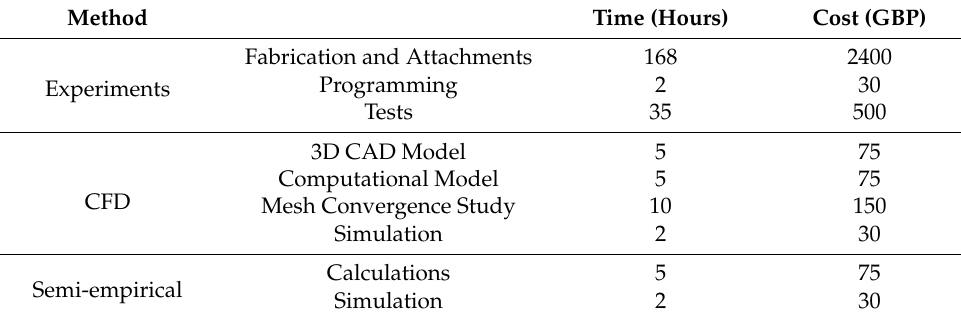
Table 9. Time and cost estimate of experiments, CFD and semi-empirical methods. Method Time (Hours) Cost (GBP) Fabrication and Attachments 168 Programming Experiments